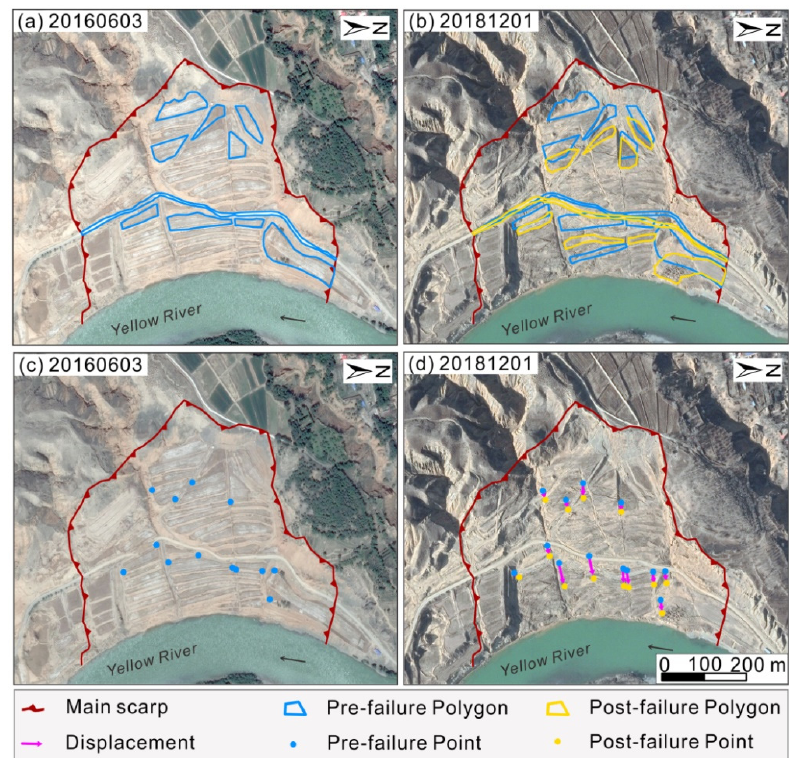
Figure 5. Surface travel distance of Simencun landslide: ( a , b ) ground objects, ( c , d ) feature points.